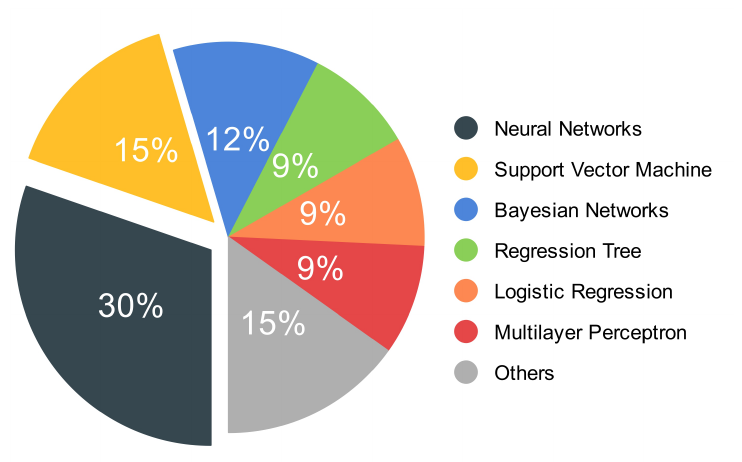
Figure 2. Distribution of algorithms in traffic accident prediction